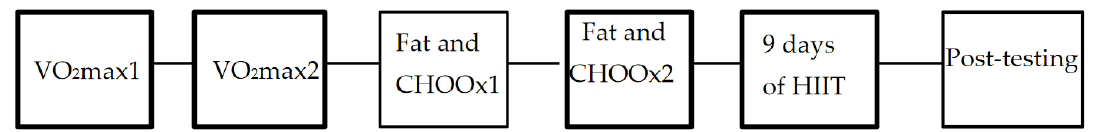
Figure 1. Experimental design. HIIT: high intensity interval training; CHOOx: carbohydrate oxi- dation